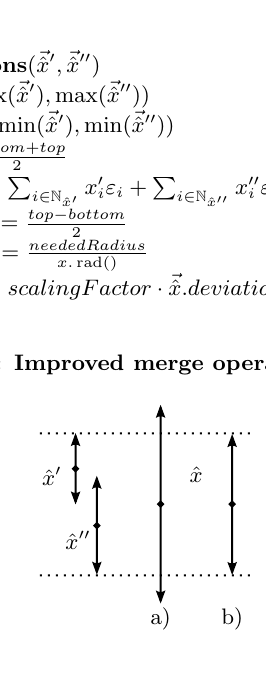
Figure 4: Merge with overlapping range, a) merge (Fig. 2), b) improved merge (Fig. 3)